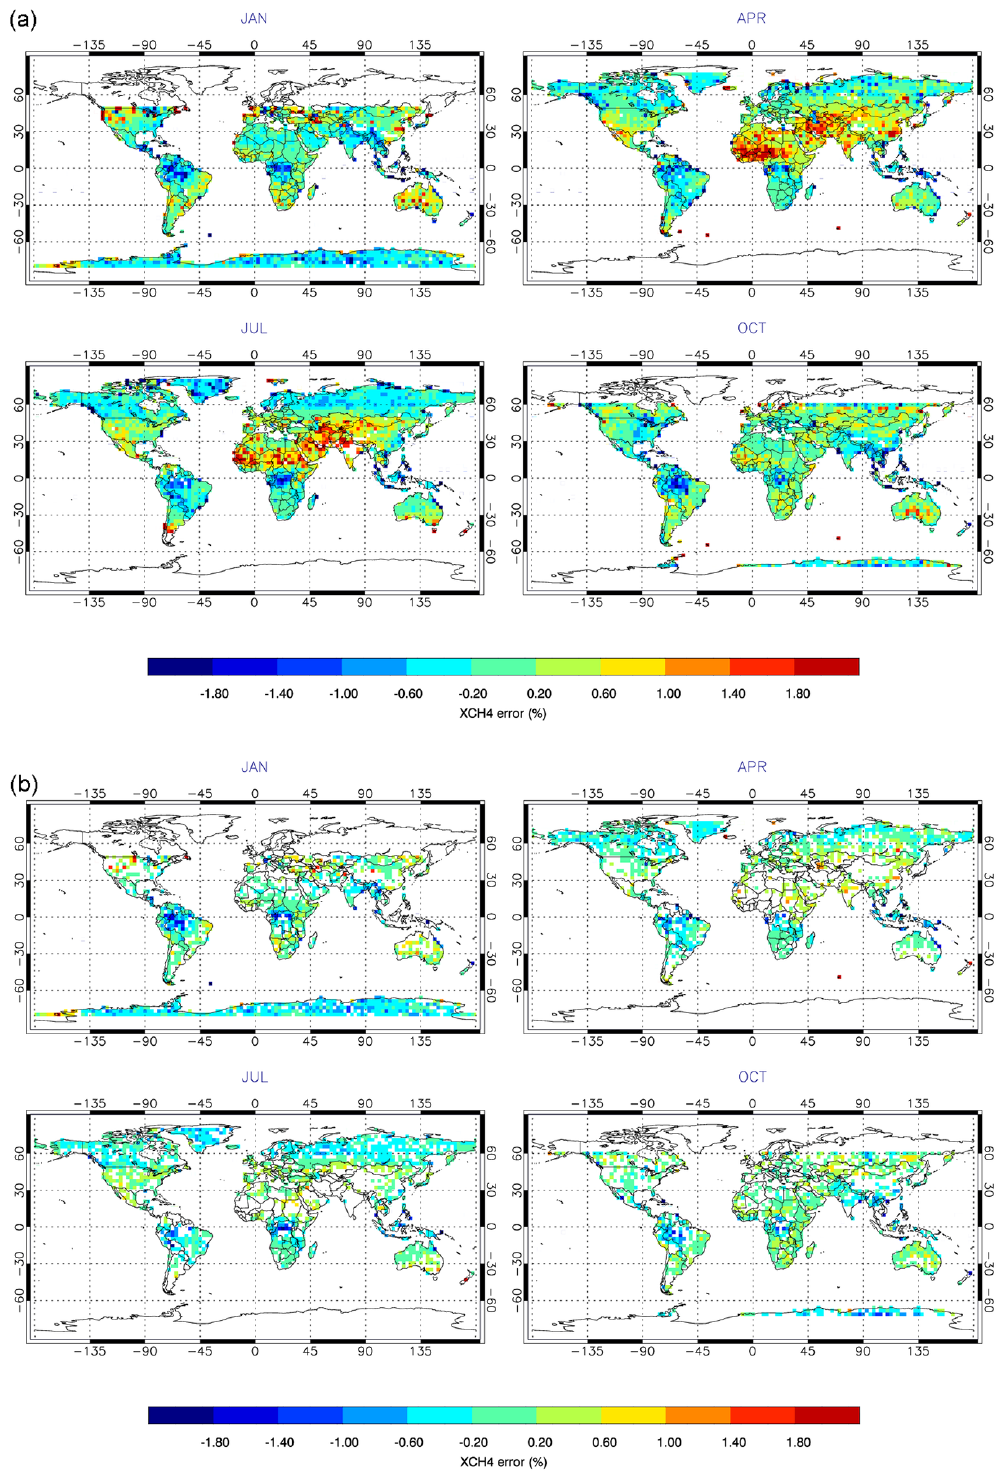
Figure 4. Residual forward model XCH 4 errors for the baseline retrieval method for the clear-sky global TROPOMI measurement ensemble before (a) and after (b) a posteriori filtering. The ensemble covers scenes for a day in January (JAN), April (APR), July (JUL) and October (OCT) as described in Sect.